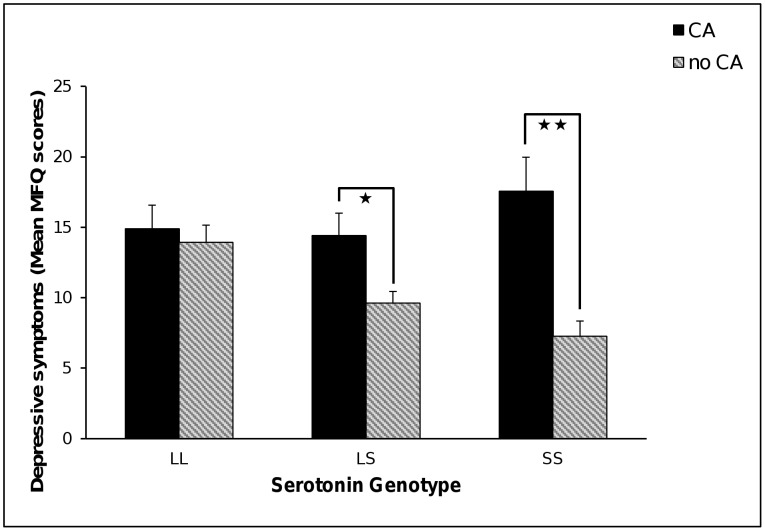
Mean scores of self-reported depressive symptoms by gene variants in 5-HTTLPR and early childhood adversities (CA).Error bars represent ±1 SE of the mean. * p<0.05; ** p<0.001.